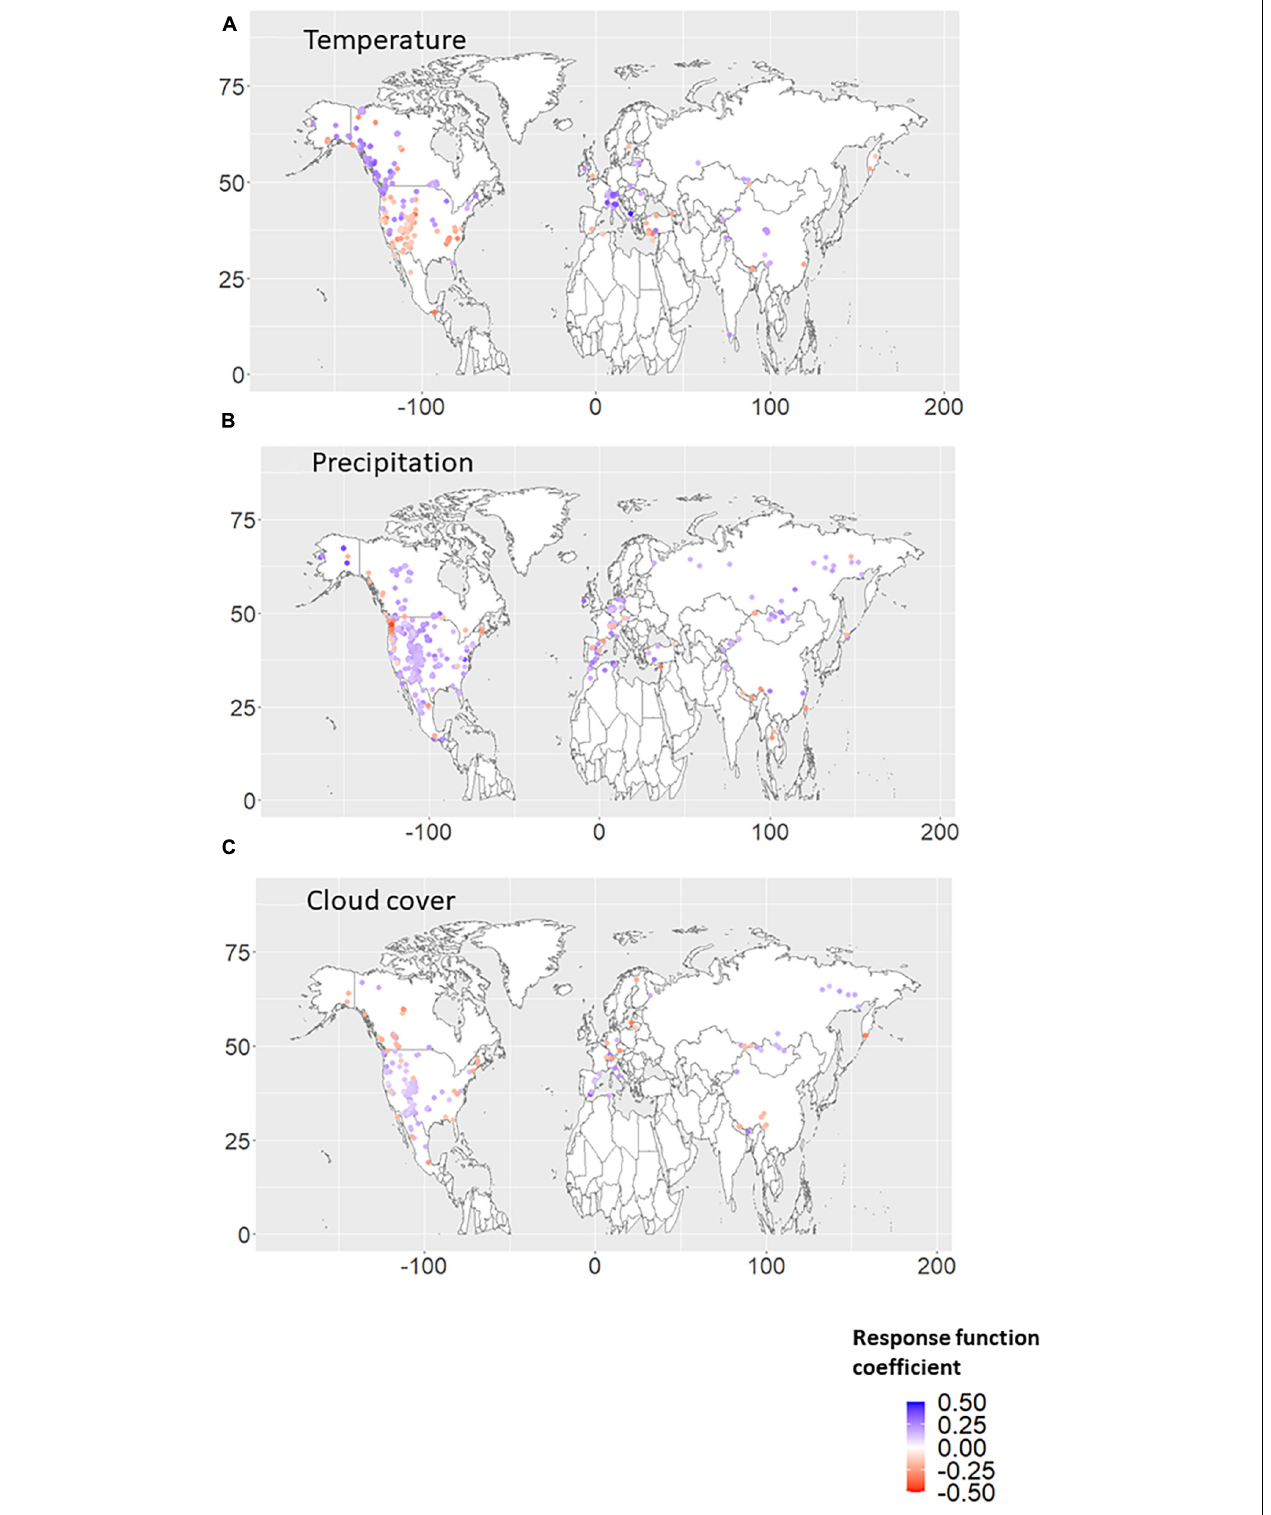
FIGURE 2 | Response function (RF) coefficients between RWI and climate variables, i.e., (A) temperature, (B) precipitation, and (C) cloud cover, in the autumn season of the previous year. The period when both RWI and climate data existed in duplicate during 1901–2016 was used for the analysis. Only the RWI sites where the RF coefficient was significant ( p < 0.10) are